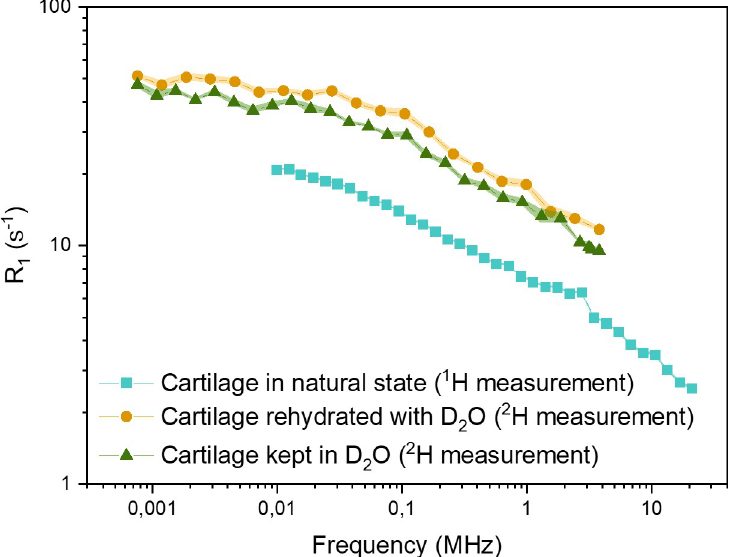
Fig 10. T 1 dispersion curves of the cartilage samples kept under different conditions: Fresh cartilage (squares) - 1 H measurements; dried cartilage rehydrated in D 2 O (circles); fresh cartilage kept in D 2 O until complete exchange, in two cycles (triangles) - 2 H measurements. The error bars for each exponential fit are smaller than the corresponding symbol size.